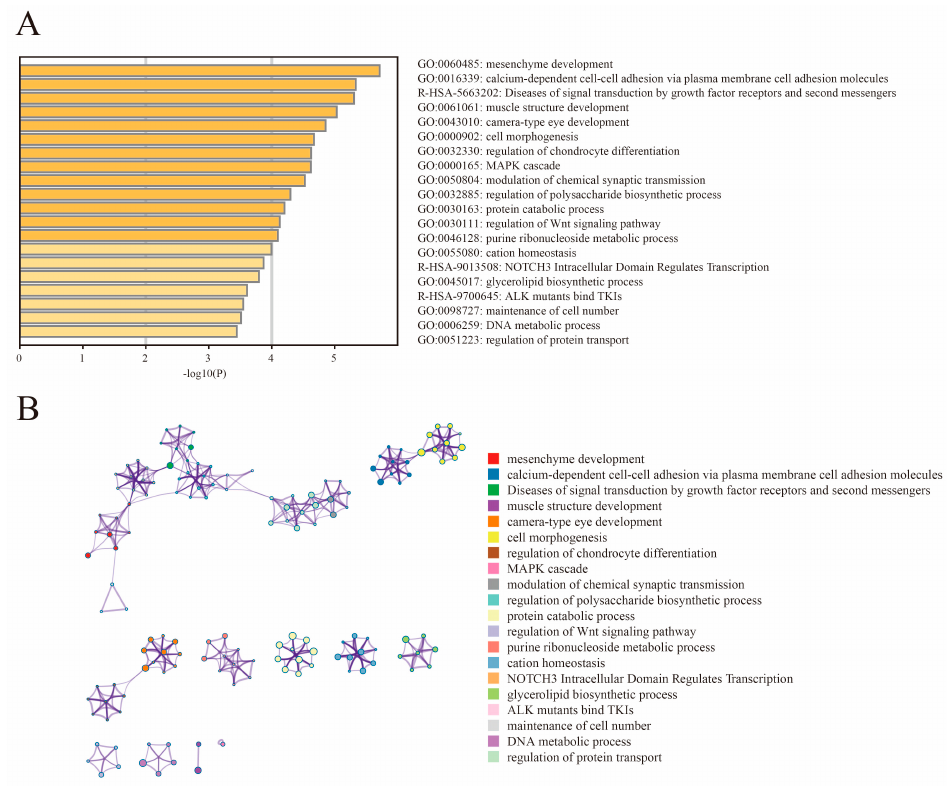
Figure 5. Functional enrichment analysis of 399 selected genes. ( A ) Enrichment heatmap. ( B ) Cluster analysis of enrichment pathways or biological process subclasses, colored by cluster ID, where nodes that share the same cluster ID are typically close to each other.